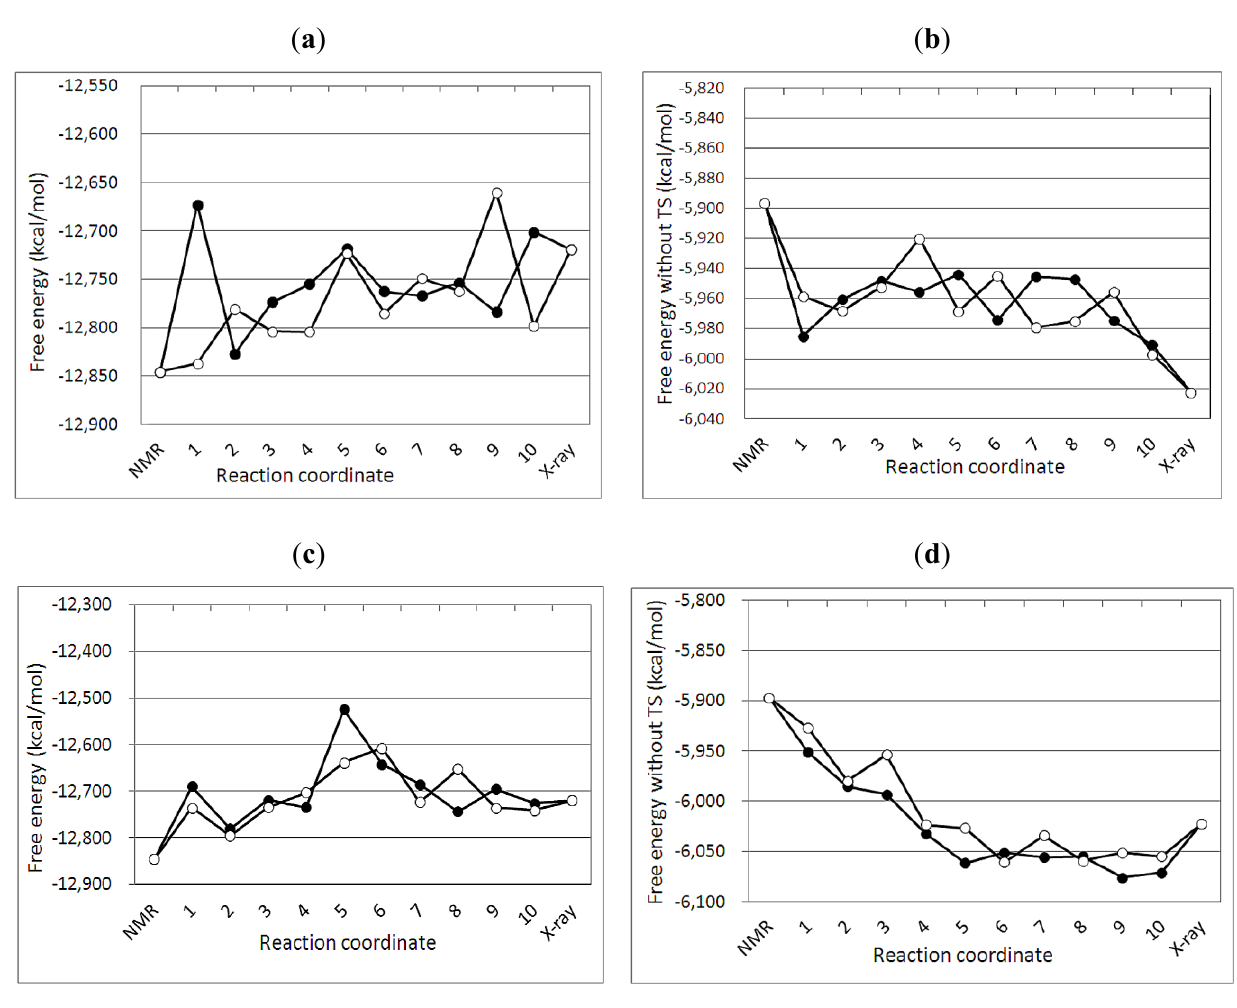
Figure 3. Free energy profiles of targeted MDs between the NMR and the crystal structures of A3Gctd. ( a ) and ( b ) show free energy G1(with entropy) and G2(without entropy) profile, respectively, along the reaction path from the NMR (2KEM) to the crystal (3IR2) structure. Numbers in the X axis correspond to the numbers (selected structures) in Figure 2a. ( c ) and ( d ) show free energy G1(with entropy) and G2(without entory) profile, respectively, along the path from the crystal to the NMR structure. Numbers in the X axis correspond to the numbers (selected structures) in Figure 2b.Two MD simulations were performed with different initial velocities for each path way, and filled circles and open circles represent the data obtained from the first and the second MD simulations,